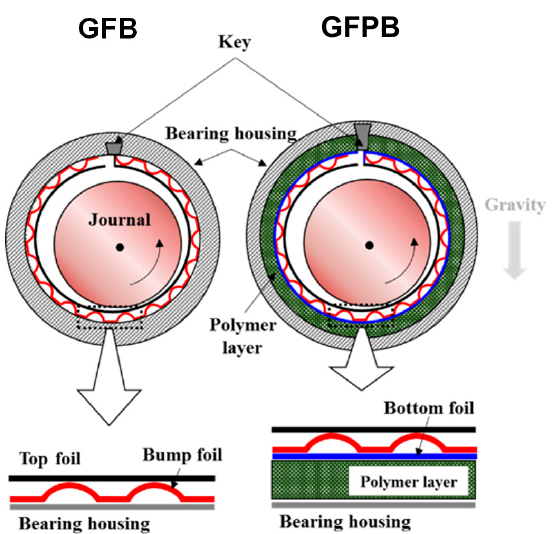
Figure 1. Schematic views of a one-pad journal gas foil bearing (GFB) with top and bump foil structures and gas foil-polymer bearing (GFPB) with top and bump foil structures as well as a polymer layer.